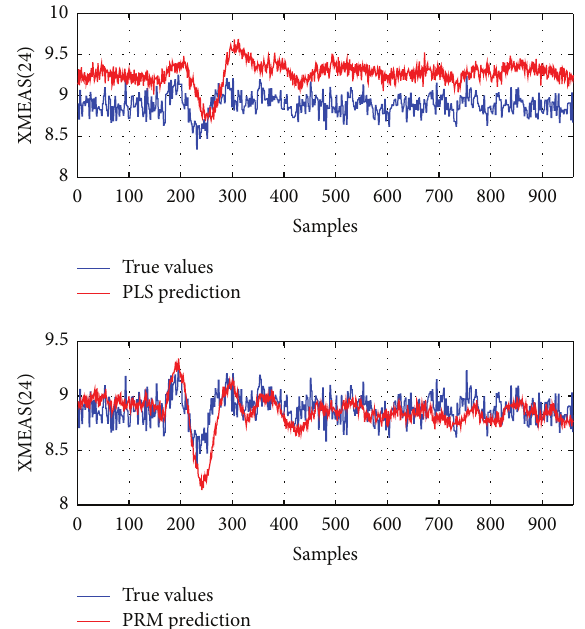
Figure 3: Quality-related indicator prediction using PLS and PRM with 5% outliers.